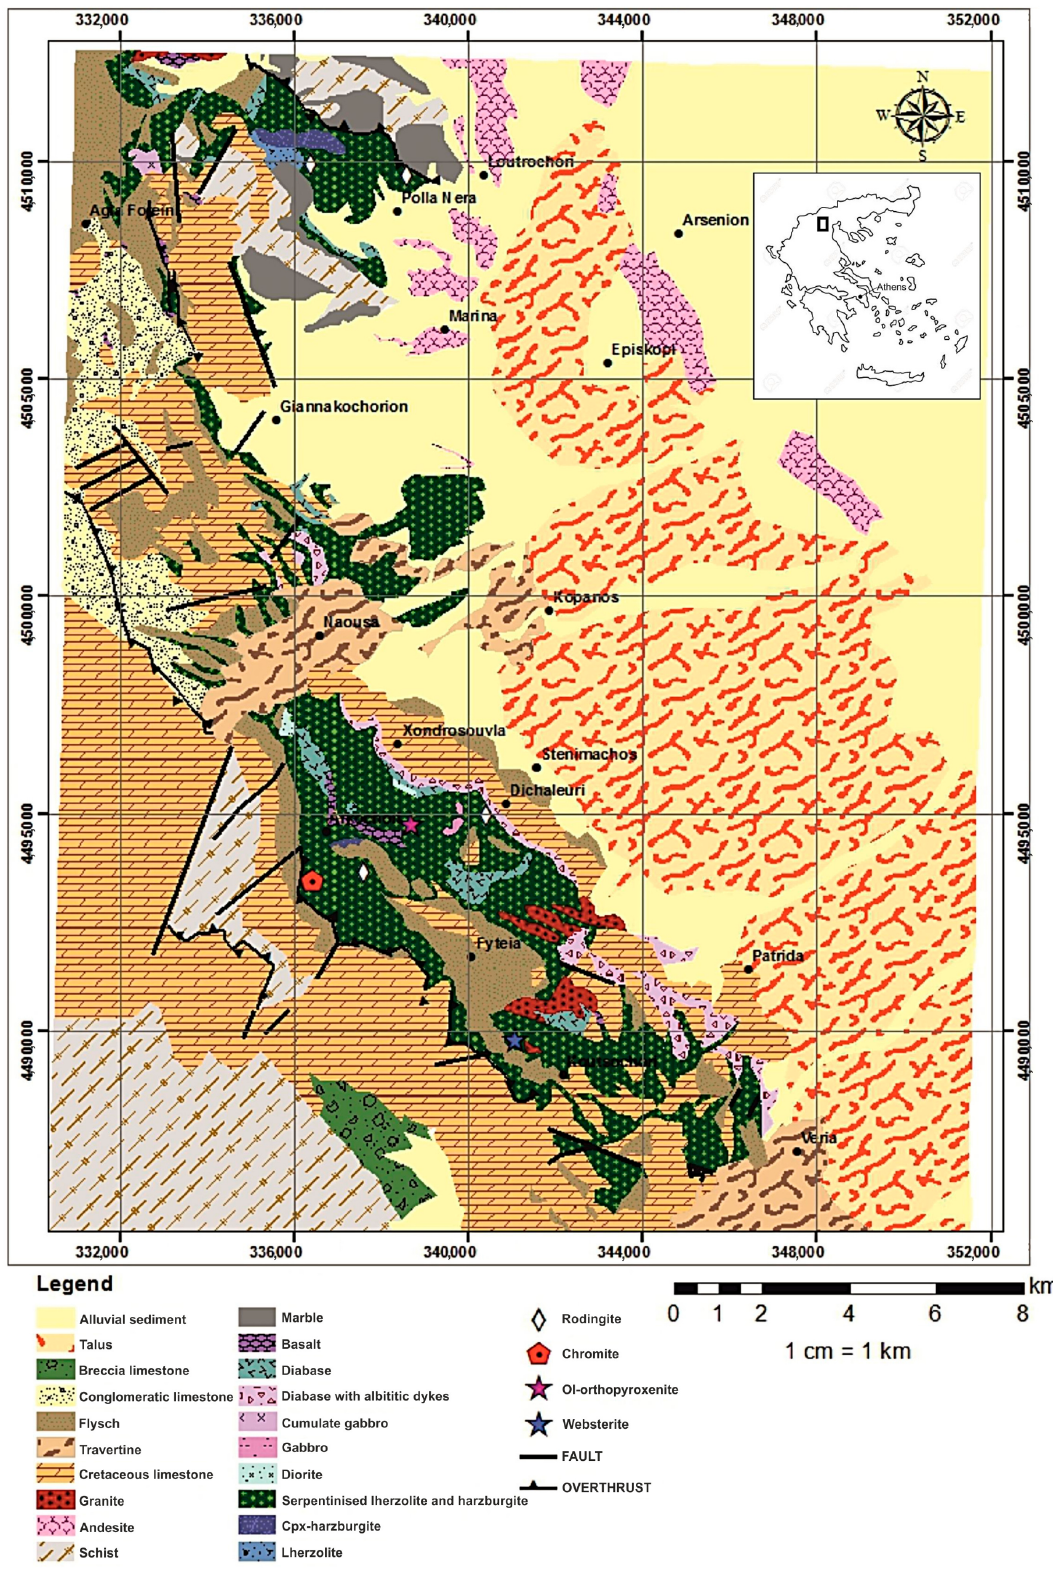
Figure 1. Geological map of the Veroia sheet IGME [31] (modified after fieldwork and mapping by using ArcMap 10.1); black rectangle in the inset shows the study